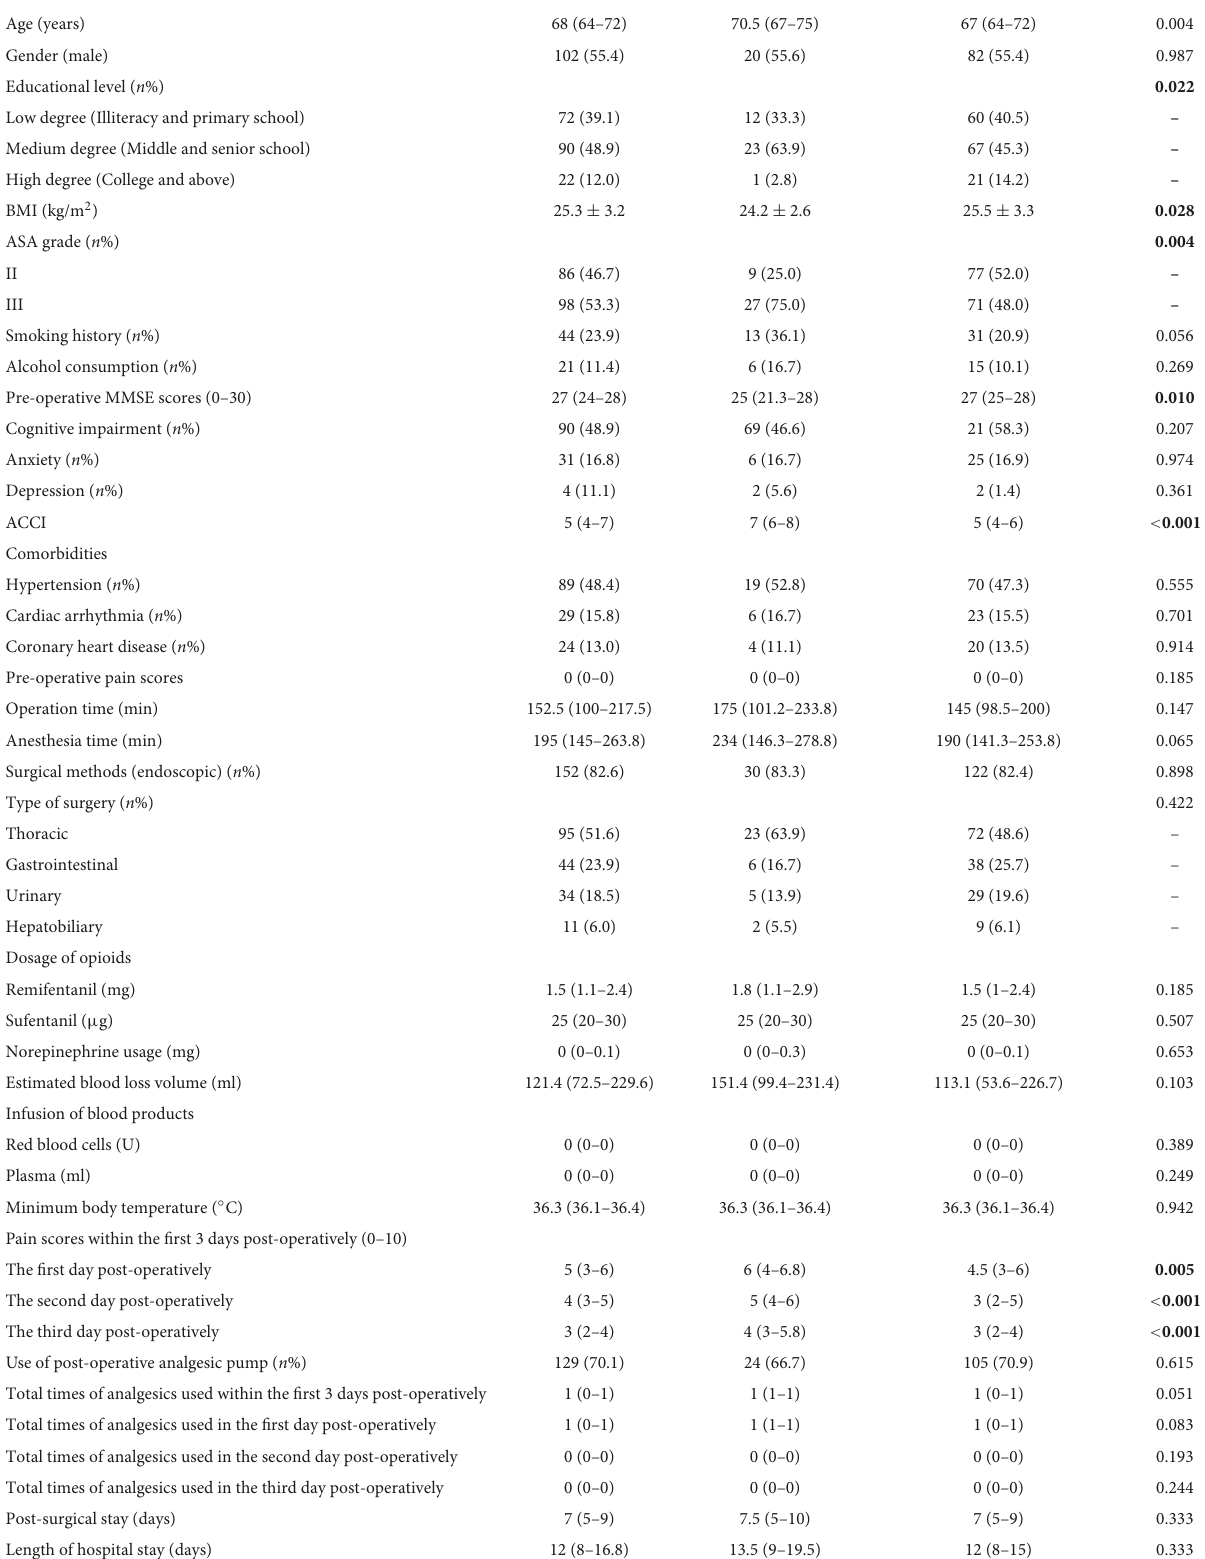
TABLE 1 Comparison of demographic and clinical data between two